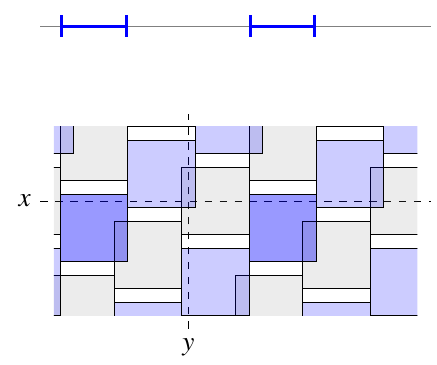
Figure 6: Second case of Lemma 25, in the case (cid:96) = 3: two distinct vertical translates of W k + 1 + (cid:101) Λ k + 1 intersect (the first translate contains the dark blue thickening of W k + (cid:101) Λ k , the second is represented in